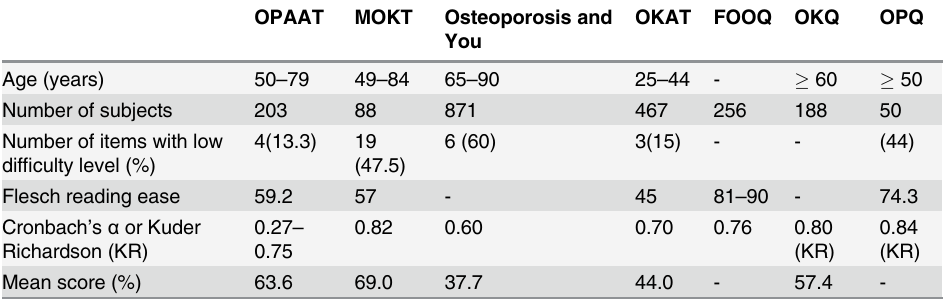
Table 11. Comparison of psychometric properties of the Osteoporosis Prevention And Awareness Tool (OPAAT).